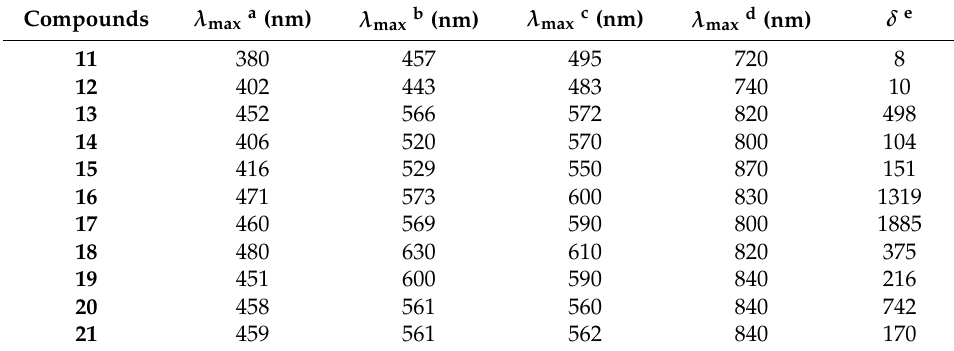
Table 2. Photophysical data of 11 – 21 .